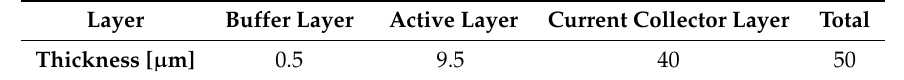
Table 2. Layers of the